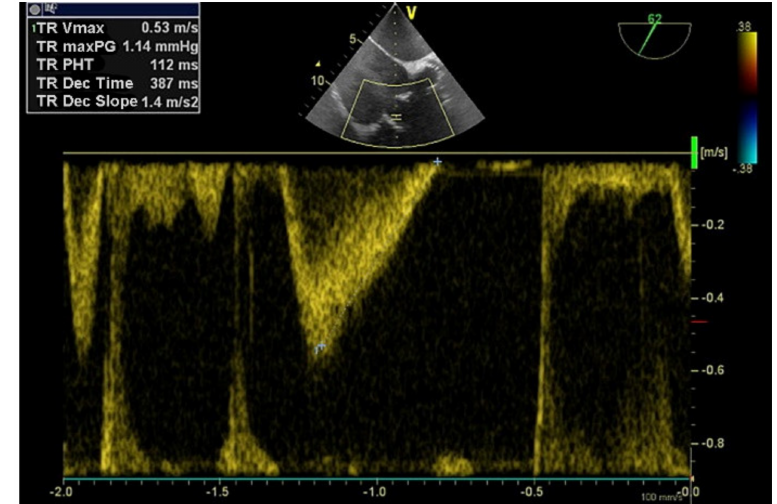
Figure 5. Transoesophageal echocardiography mid-oesophageal four-chamber incidence confirming the normal functioning the tricuspid bioprosthetic valve-in-valve with a maximum transvalvular gradient of 1.14 mmHg and a peak velocity of 0.53 m / s, suggesting substantial reduction in gradient severity after transcatheter valve